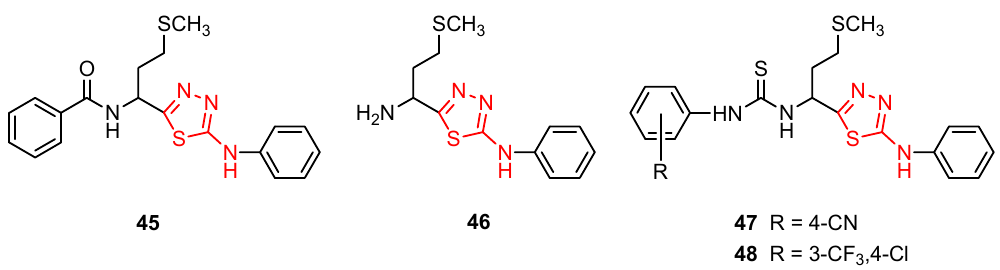
Table 5. Antiviral evaluation and in vitro cytotoxicity of compounds 45 – 48 (adapted from [49]).